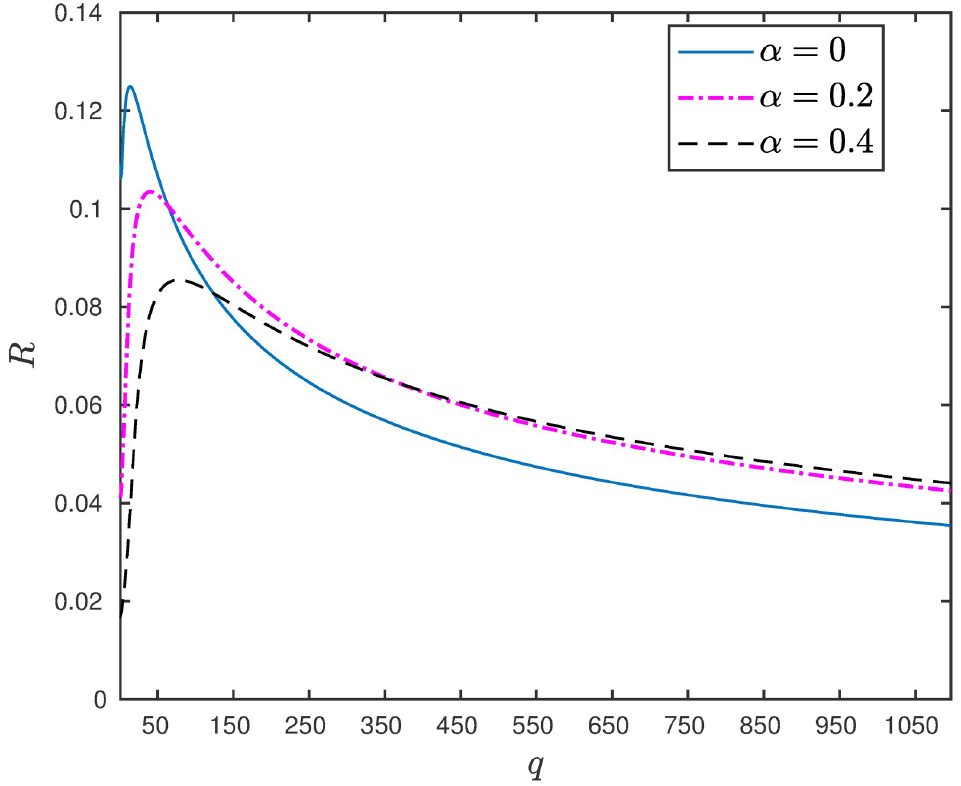
Fig 4. The steady-state output rate R as a function of q for a EFEIOD with n = 9, ℓ = 3, λ 0 = 1, λ